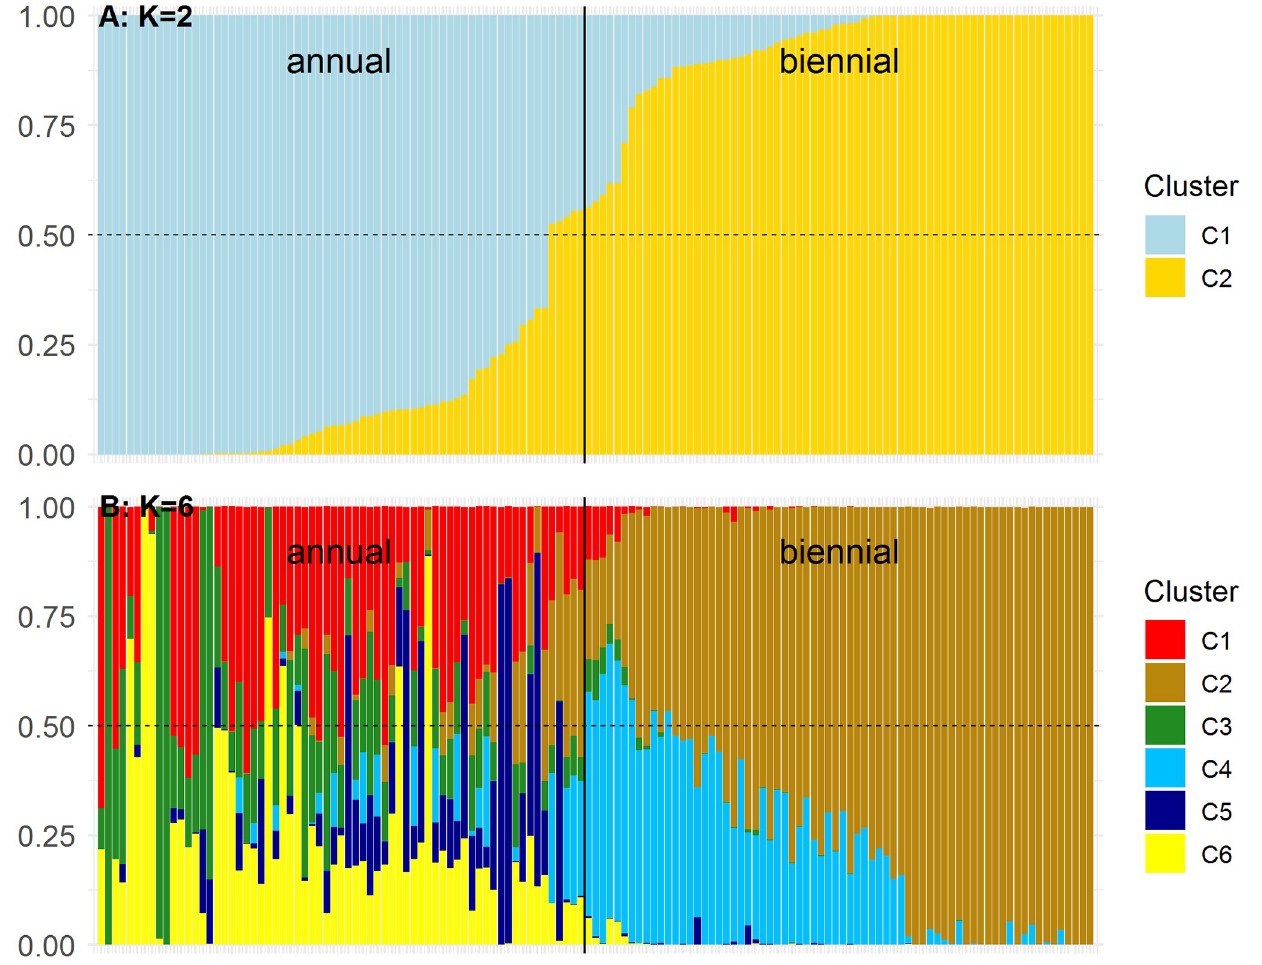
Fig 3. Estimated membership coefficients of 137 caraway accessions based on 13,155 SNP loci using STRUCTURE software. For (A) K = 2 and (B) K = 6. Accessions are sorted by decreasing membership coefficient for C1 (K = 2). The dashed line indicates the threshold of 0.5.